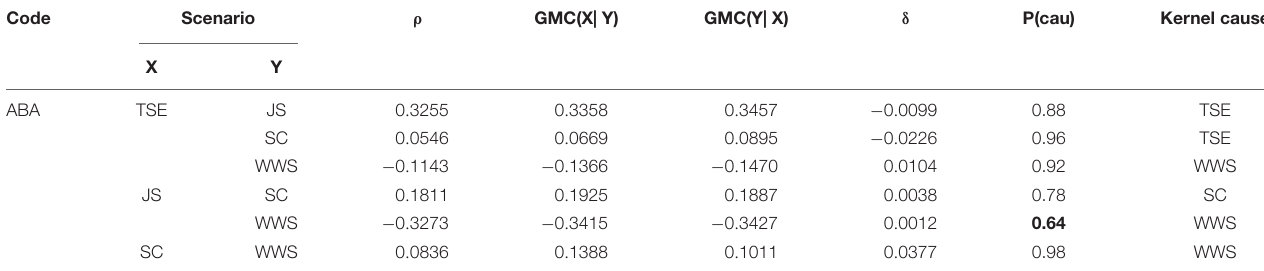
TABLE 4 | Summary of GMC for CABA – Argentina.